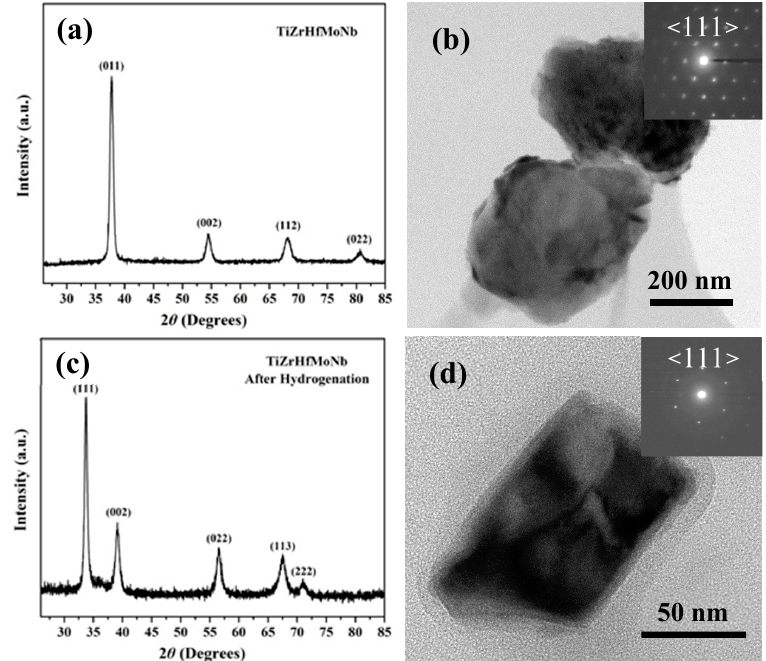
Figure 1. XRD pattern ( a ) and SAED pattern ( b ) of the as-obtained TiZrHfMoNb alloy and XRD pattern ( c ) and SAED pattern ( d ) of the TiZrHfMoNb alloy after full hydrogenation (five hydrogen absorption–desorption cycles).